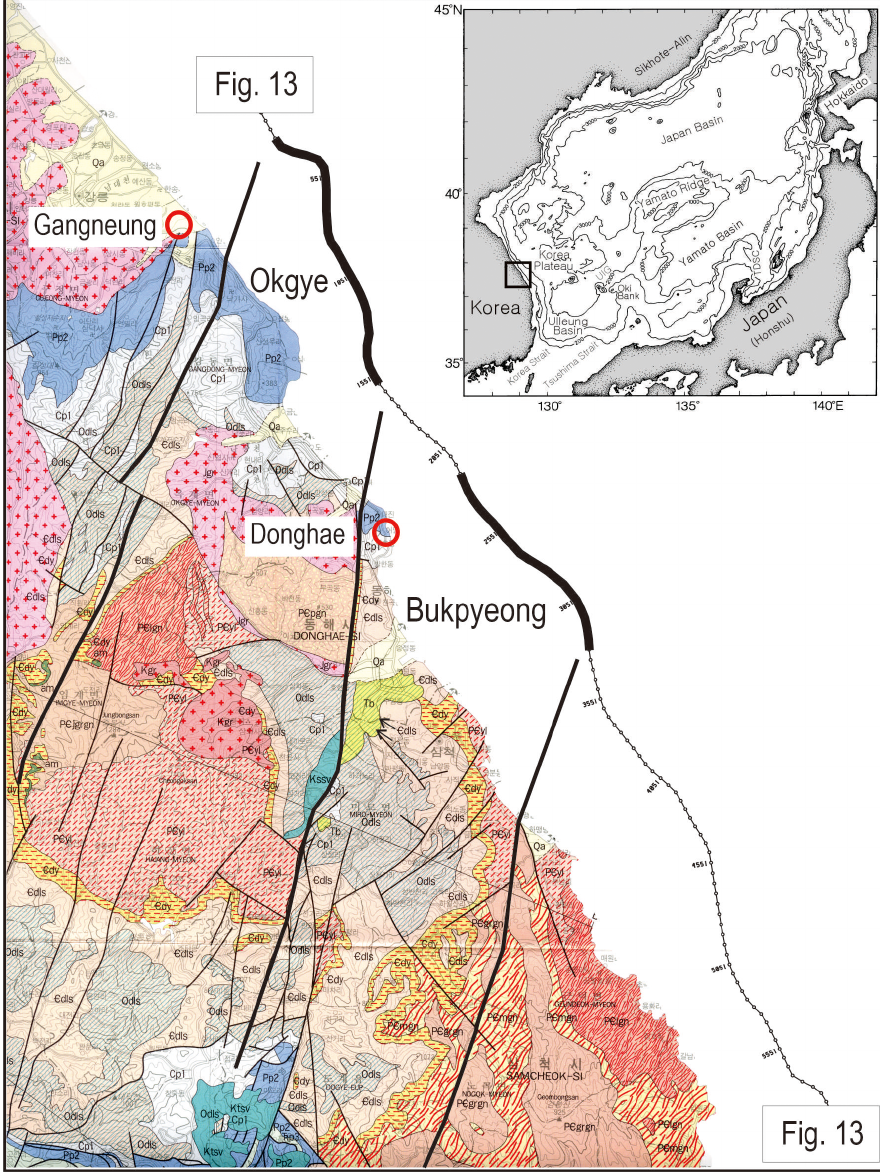
Figure 12. Geological map (1 : 250000) and seismic track line around the Gangneung and Donghae areas (modified after Kim et al., 2001; Ryang et al., 2007, 2014). The multichannel seismic profile with interpretation is shown in Fig. 12. Red circles indicate the locations of LIG ages in Fig. 2. Solid lines indicate major strike-slip or thrust faults. Two thicker parts of the track line represent the interval of thick sedimentary bodies in the seismic profile of Fig. 12. Inset shows this figure area (solid rectangle) and adjacent land and sea (Chough et al., 2000). Legend codes of the geologic map (Kim et al., 2001): Qa, Quaternary alluvium; Tb, Tertiary Bukpyeong group; Kgr, Cretaceous granite; Kssv, Ktsv, Cretaceous Kyeongsang supergroup; Jgr, Jurassic granite; Pp2, Permian middle Pyeongan group; Cp1, Carboniferous lower Pyeongan group; Odls, Ordovician upper great limestone group; (cid:15) dls, Cambrian lower great limestone group; (cid:15) dy, Cambrian Yangduk group; P (cid:15) jgrgn, P (cid:15) grgn, P (cid:15) lgn, P (cid:15) mgn, P (cid:15) yl, Precambrian Metamorphic